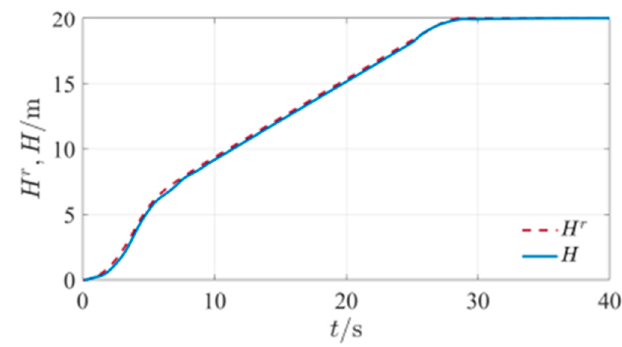
Figure 19. The track diagram of line tracking using ATD guidance law.